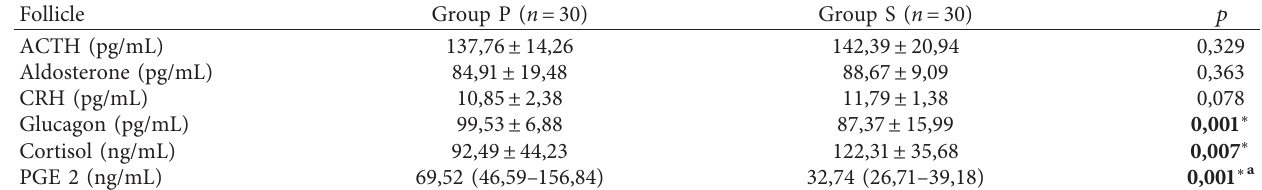
Table 3: Comparison of follicular fluid levels between groups P and S.